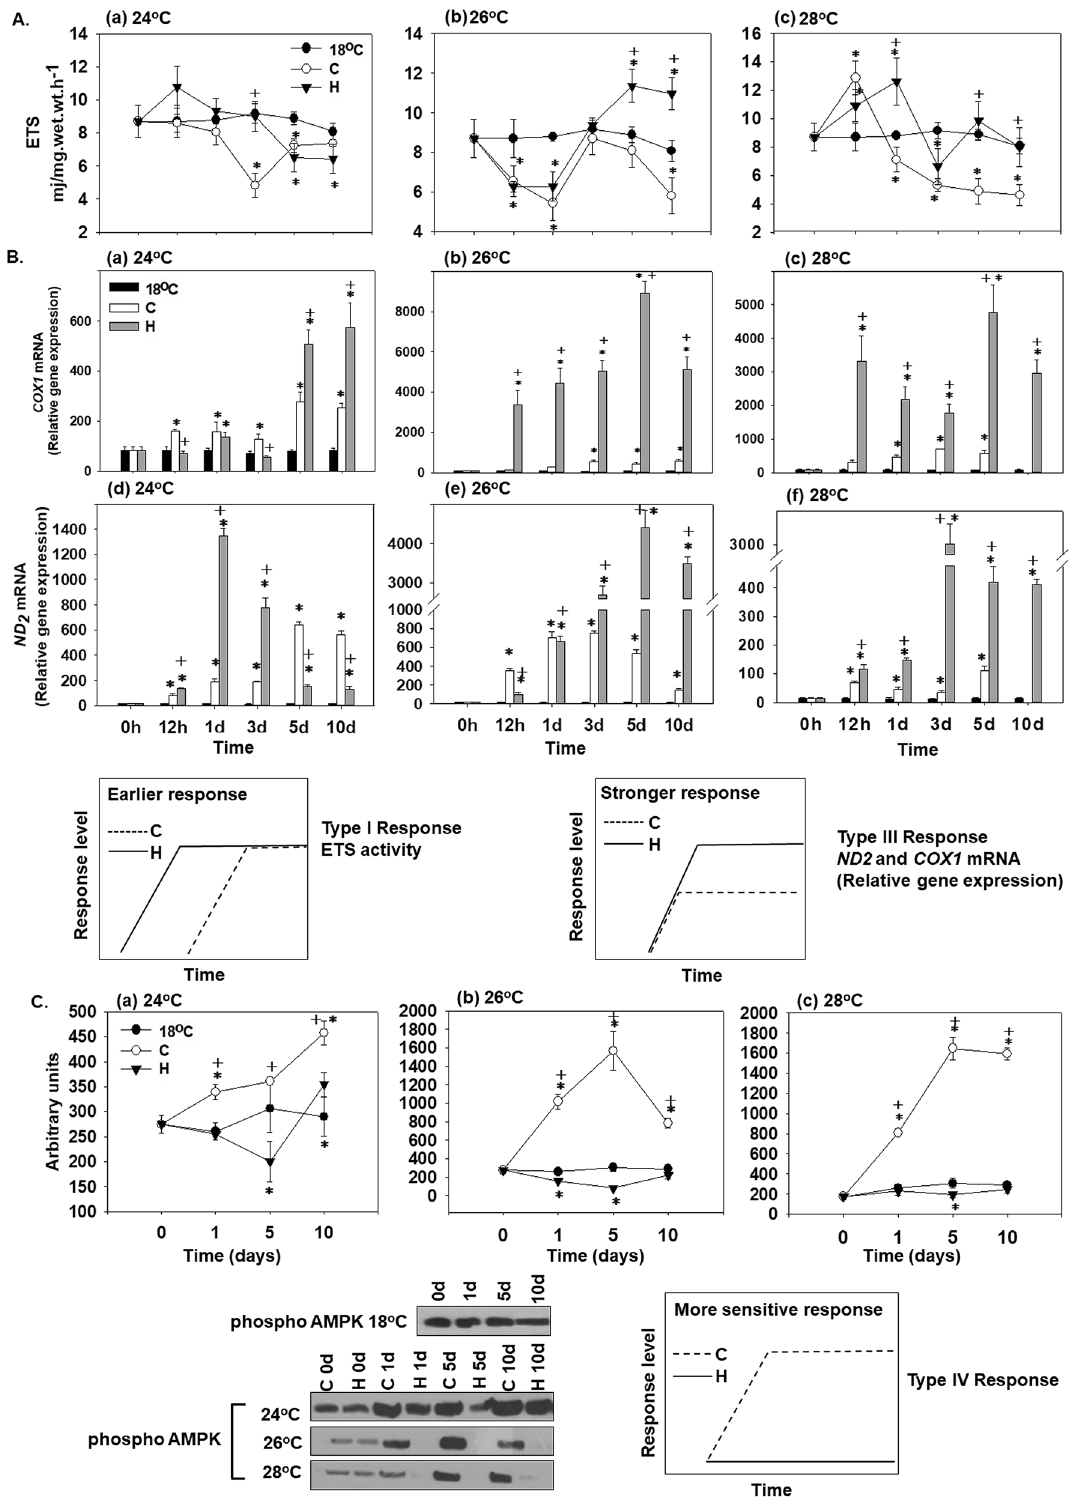
Figure 2. Changes in ( A ) the ETS activity [Type I (earlier) response], ( B ) the relative COX1 and ND-2 mRNA levels [Type III (stronger) response] and ( C ) AMPK phosphorylation levels [Type IV (more sensitive) response] in the mantle of heat hardened (H) and non-hardened (C) Mytilus galloprovincialis when exposed to 24 °C (a,d), 26 °C (b,e) and 28 °C (c,f) compared to control at 18 °C. Representative blots are shown. Blots were quantified using scanning densitometry. Full-length blots/gels are presented in Supplementary Fig. 1. Values are means ± SD, n = 8 preparations from different animals. * p < 0.05 compared to day 0, + p < 0.05 compared to non- hardened (C)